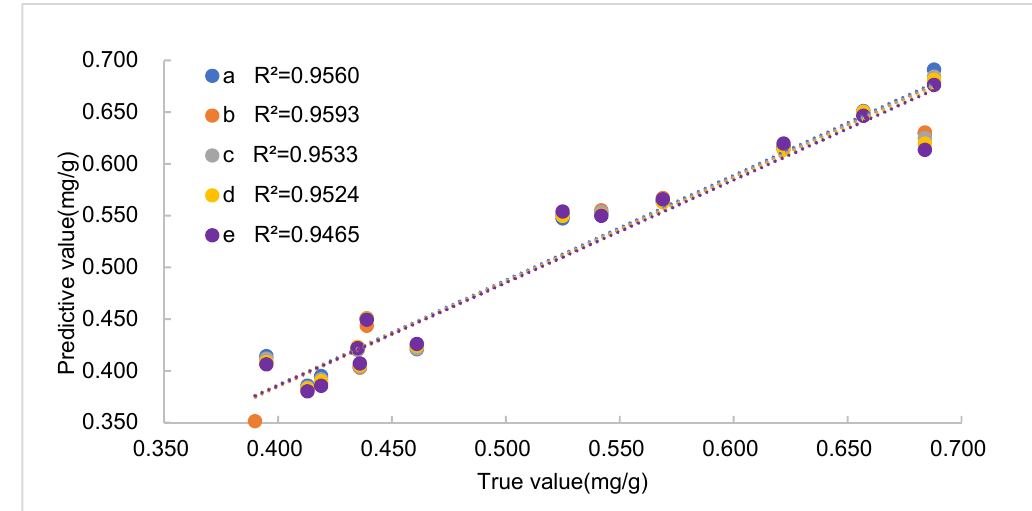
Figure 5. Five multiple linear regression (MLR) models with different characteristic features were established to predict the results. a: All color features; b: principal component features extracted from all color features by principal component analysis; c: average features of all colors; d: principal component features extracted from principal component analysis of color average features; e: R_mean, G_mean, B_mean, and Gray_mean.